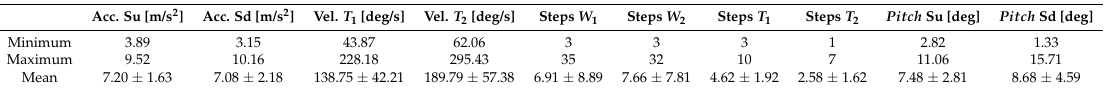
Table 7. Characteristics obtained after the implemented segmentation of the activities performed by the older adults group during the TU & Go